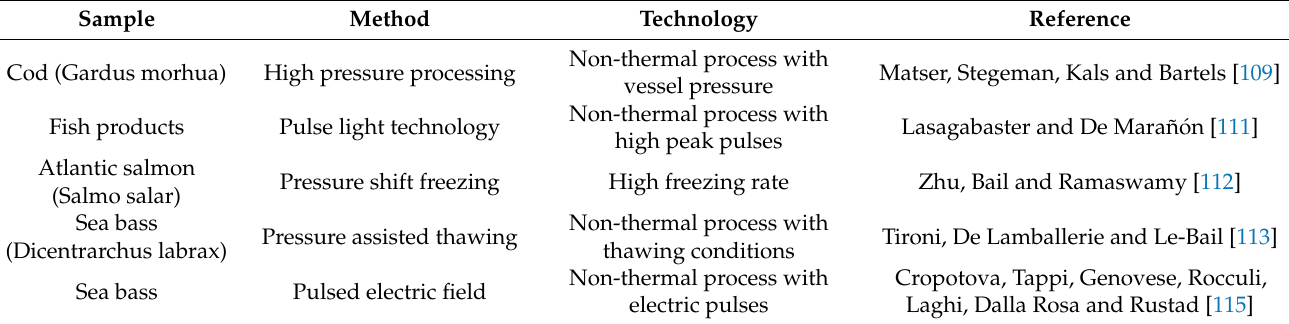
Table 4. Processing methods for preserving the quality of fish